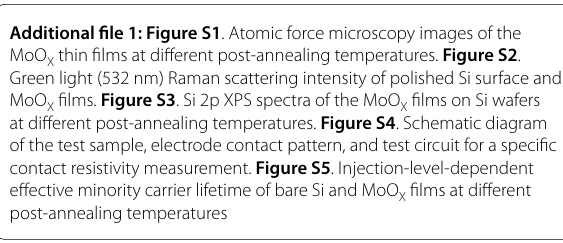
MoO X films. Figure S3 . Si 2p XPS spectra of the MoO X films on Si wafers at different post-annealing temperatures. Figure S4 . Schematic